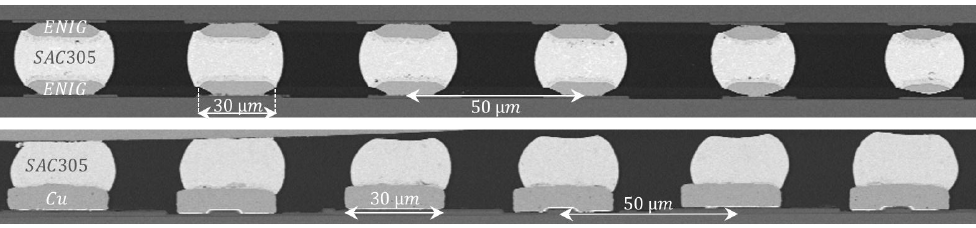
Figure 8. Cross-sectional view of ENIG30-SAC-ENIG30 bonded module ( top ) and a bumped Cu30/50 sample ( bottom ), both at 50µm